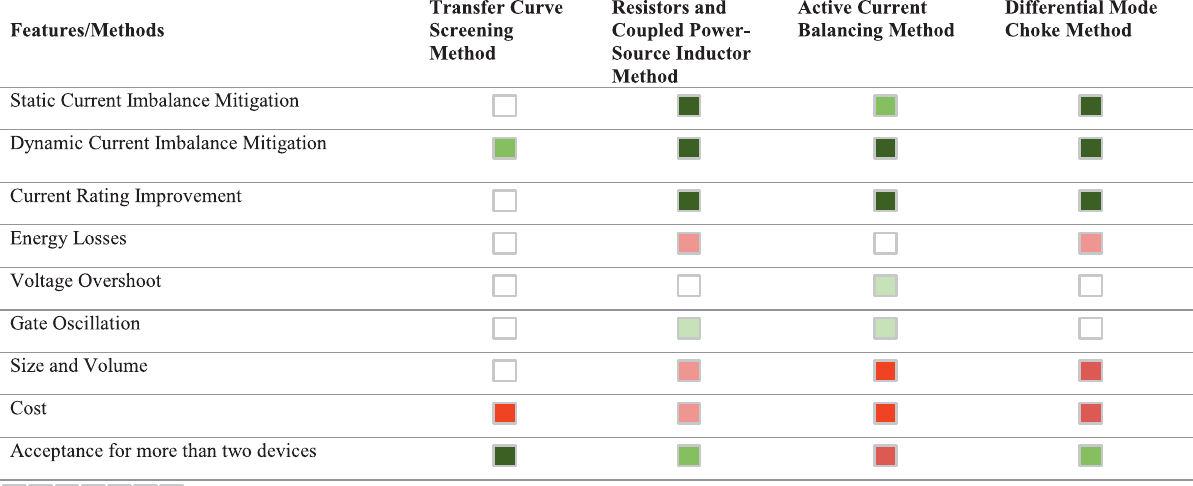
TABLE 2 | Evaluation of advanced current imbalance mitigation